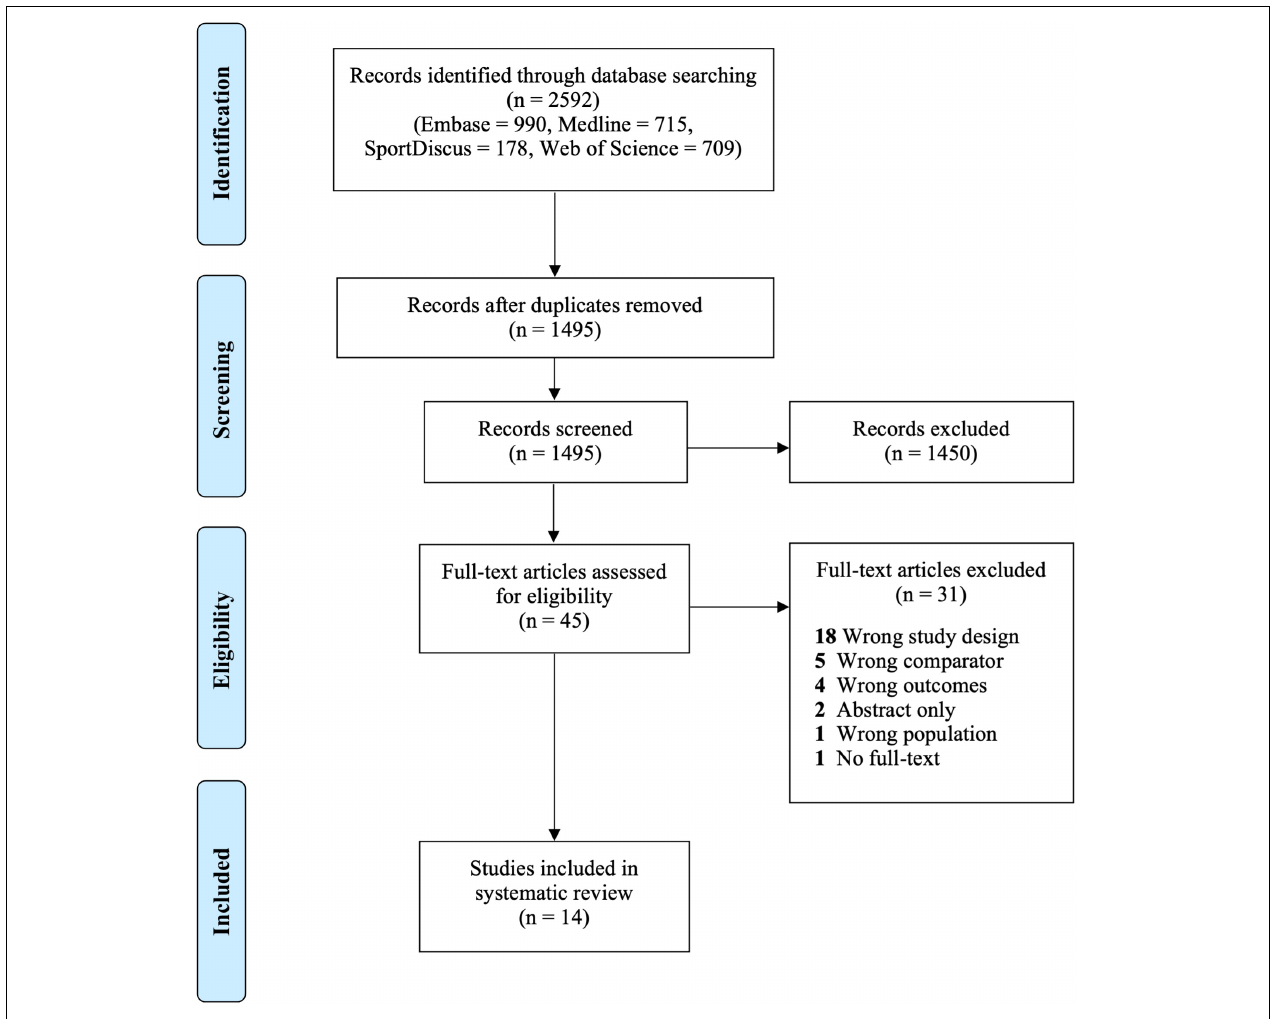
FIGURE 1 | PRISMA flow